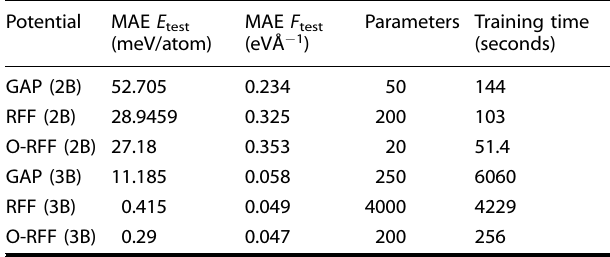
The metric used is mean absolute error. GAP model was trained considering only 2 body interactions, denoted as GAP (2B) and considering 3 body interactions only, denoted as GAP (3B). Training time is measured in seconds.